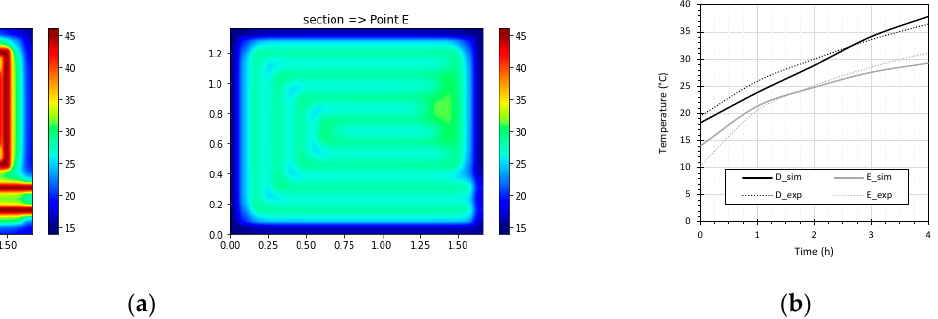
Figure 8. ( a ) Temperature distribution in two sections (point (D) and point (E)); ( b ) comparison between recorded and simulated data.